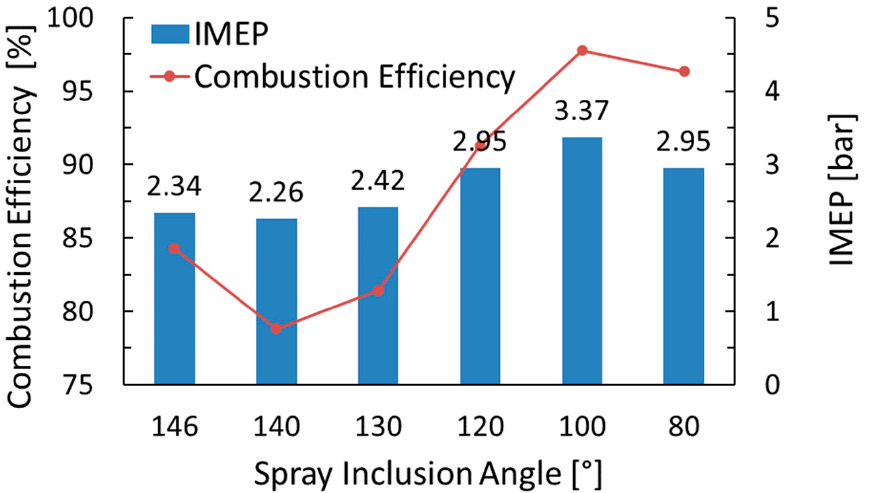
Figure 41. CE and IMEP for various SIAs.